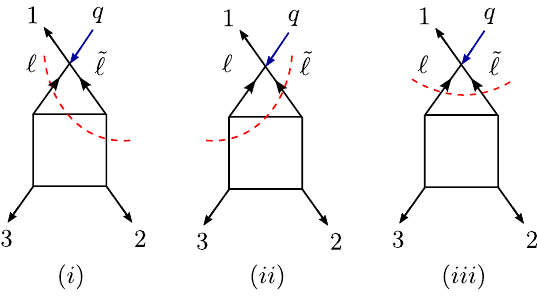
Figure 14 . Three cuts of one of the integral